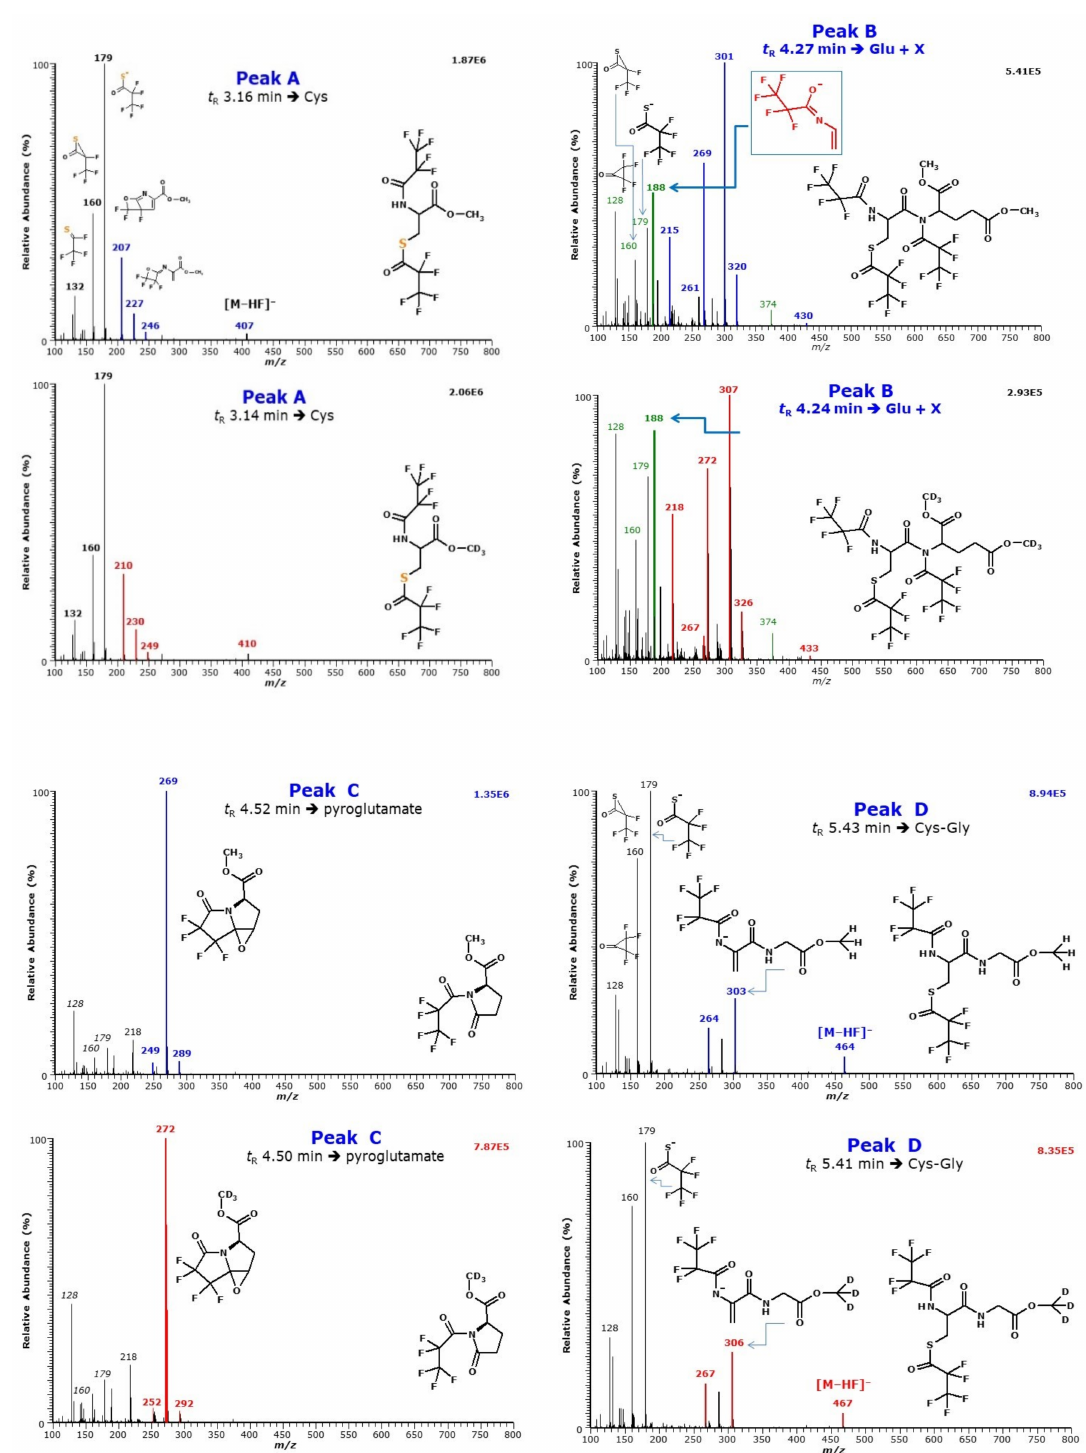
Figure 2. GC-MS spectra in the ECNICI mode of the peaks A, B, C and D, obtained from separate analysis of GSH (each 10 nmol) after its esterification (60 min, 80 ◦ C) in 2 M HCl/CH 3 OH or 2 M HCl/CD 3 OD and subsequent acylation with PFPA (30 min, 65 ◦ C). Oven temperature program TP#1 was used. The quadrupole was scanned in the m / z -range 100–1000 (1 scan/s). Inserts indicate the proposed structures for the derivatives and the mass fragments. The B peaks contain Glu and Glu-Cys (X). Peaks A, B, C and D refer to Figure